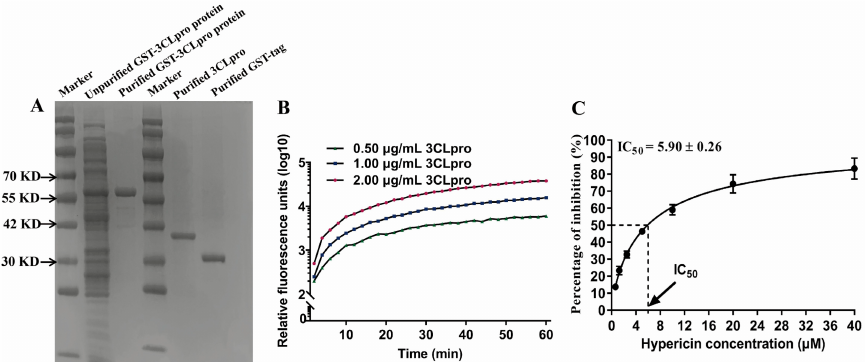
Figure 4. Hypericin impairs PEDV 3CLpro activity. ( A ) The expression and purification of PEDV 3CL- pro. ( B ) The cleavage activity on FRET substrate Dabcyl-YNSTLQ ↓ AGLRKM-E-Edans by 0.50 µ g/mL, 1.00 µ g/mL, and 2.00 µ g/mL of purified PEDV 3CLpro was monitored through the fluorescence value. ( C ) Inhibition of cleavage activity of 1.00 µ g/mL PEDV 3CLpro in the presence of increasing concentra- tions of hypericin. All data are represented as mean ± SD of at least three independent